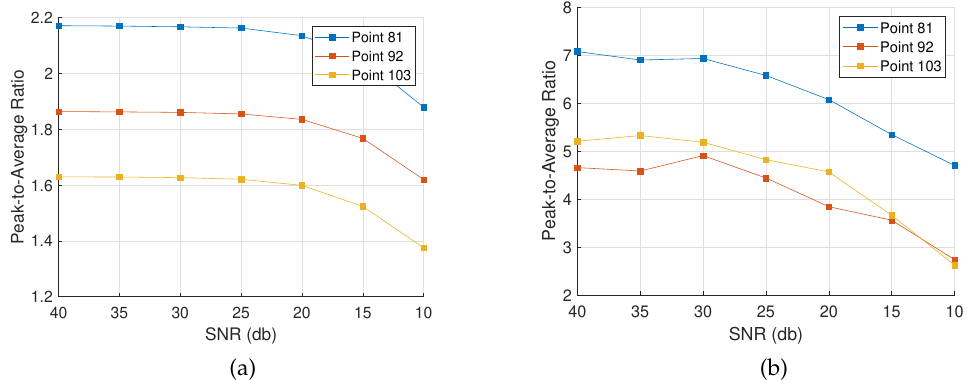
Figure 12. Peak-to-Average Ratio for damage configuration M E with varying SNR. ( a ) Complex Group Lasso. ( b ) Adaptive Complex Group Lasso.